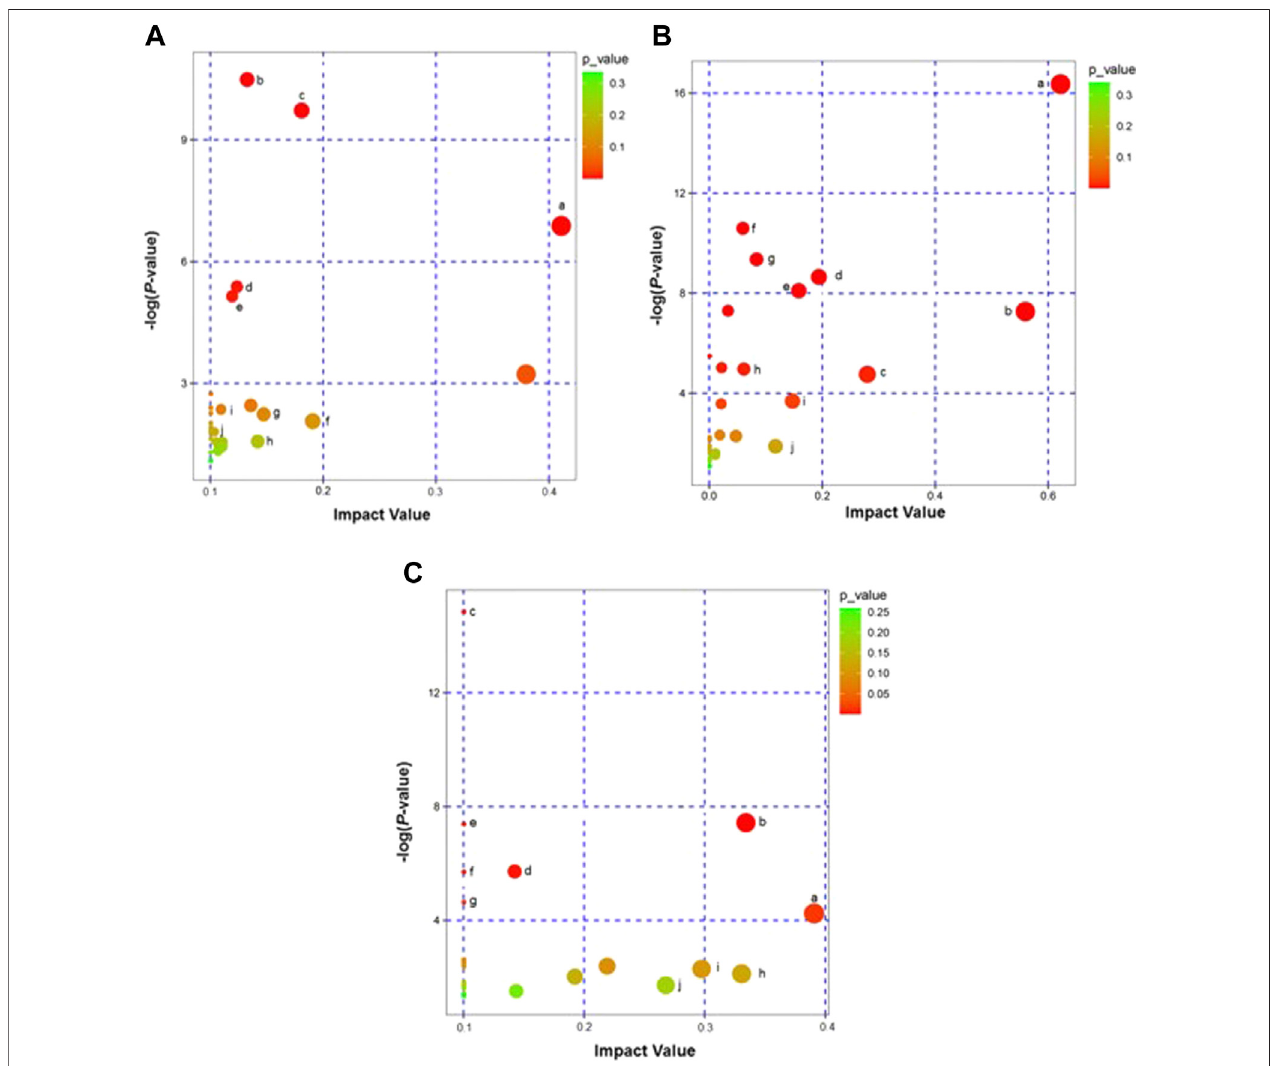
FIGURE 5 | (A) : Enrichment of metabolic pathways of DEMs in HH vs . CH groups (KEGG Topology Analysis). Note: a: D-Glutamine and D-glutamate metabolism; b: Glycerophospholipid metabolism; c: Steroid hormone biosynthesis; d: Sphingolipid metabolism; e: Purine metabolism; f: Alanine, aspartate and glutamate metabolism; g: Pentose and glucuronate interconversions; h: Glutathione metabolism; i: Linoleic acid metabolism; j: Arachidonic acid metabolism. (B) : Enrichment of metabolic pathways of DEMs in RH vs . HH groups (KEGG Topology Analysis). Note: a: D-Glutamine and D-glutamate metabolism; b: D-Arginine and D-ornithine metabolism; c: Alanine, aspartate and glutamate metabolism; d: Arginine metabolism; e: Glutathione metabolism; f: Aminoacyl-tRNA biosynthesis; g: beta-Alanine metabolism; h: Glyoxylate and dicarboxylate metabolism; i: Taurine and hypotaurine metabolism; j: Pentose and glucuronate interconversions. (C) : Enrichment of metabolic pathways of DEMs in RH vs . CH groups (KEGG Topology Analysis). Note: a: Lysine degradation; b: Glycerophospholipid metabolism; c: Alanine, aspartate and glutamate metabolism; d: Aminoacyl-tRNA biosynthesis; e: D-D-Glutamine and D-glutamate metabolism; f: Valine, leucine and isoleucine biosynthesis;